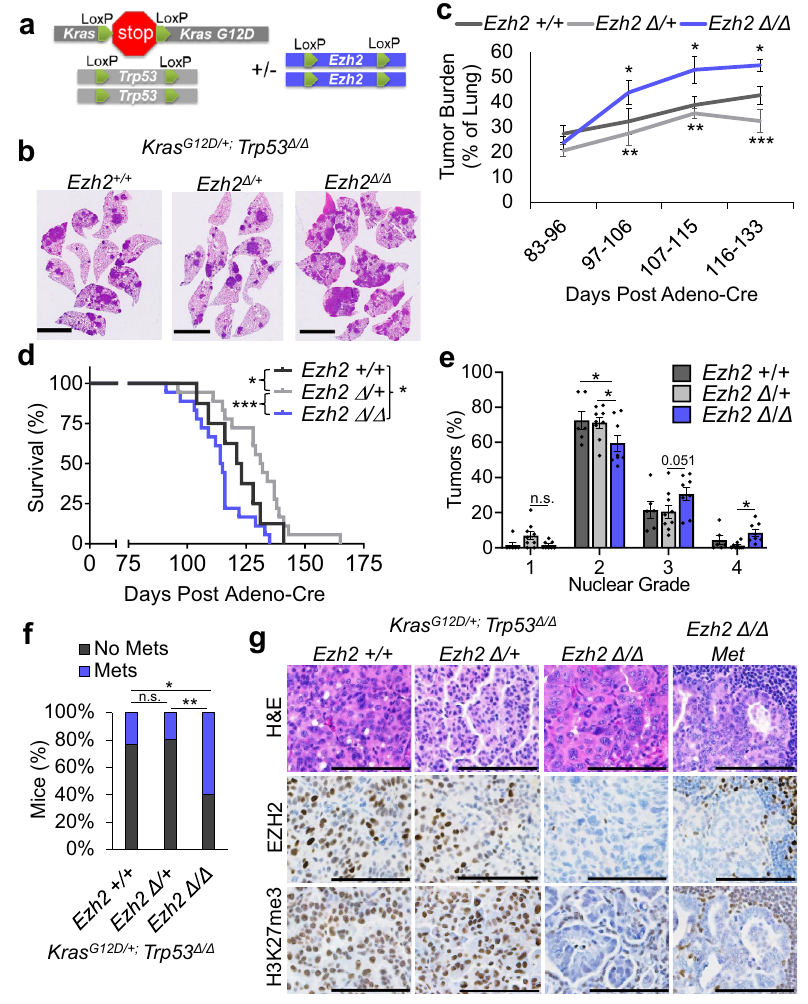
Fig. 1 | Ezh2 haplo- and full insuf fi ciency drive distinct phenotypes in KRAS +/ Trp53 -null lung cancer. a Schematic for LoxP-mediated deletion of Ezh2 to generate EZH2 WT, heterozygous, and homozygous null KRAS /Trp53-null GEMMs. b RepresentativeH&E-stainedcrosssectionsfromlungsofcloselyrelatedmicethat were induced and sacri fi ced at the same timepoint, scale bar=5mm. c Tumor burden relative to the whole lung at the different timepoints post Adeno-Cre graphed as mean values +/ − SEM. * indicates P =0.0461 Ezh2 WT vs. null Bin 2, P =0.028Bin3, P =0.0437Bin4,**indicates P =0.005,***indicates P =0.0001 Ezh2 heterozygousvs.nullbyone-wayANOVAwithmultiple comparisons. Bin1 n =4, 9, 6, Bin 2 n =10, 10, 9, Bin 3 n =11, 14,6, Bin 4 n =9, 11, 9 for Ezh2 WT, heterozygous, null individual mice, respectively. d Percentage survival of mice of indicated gen- otypes. * indicates P =0.0376 Ezh2 WT vs. Ezh2 heterozygous, *** indicates P =0.0003 Ezh2 heterozygous vs. Ezh2 null, and * indicates P =0.0397 Ezh2 WT vs.